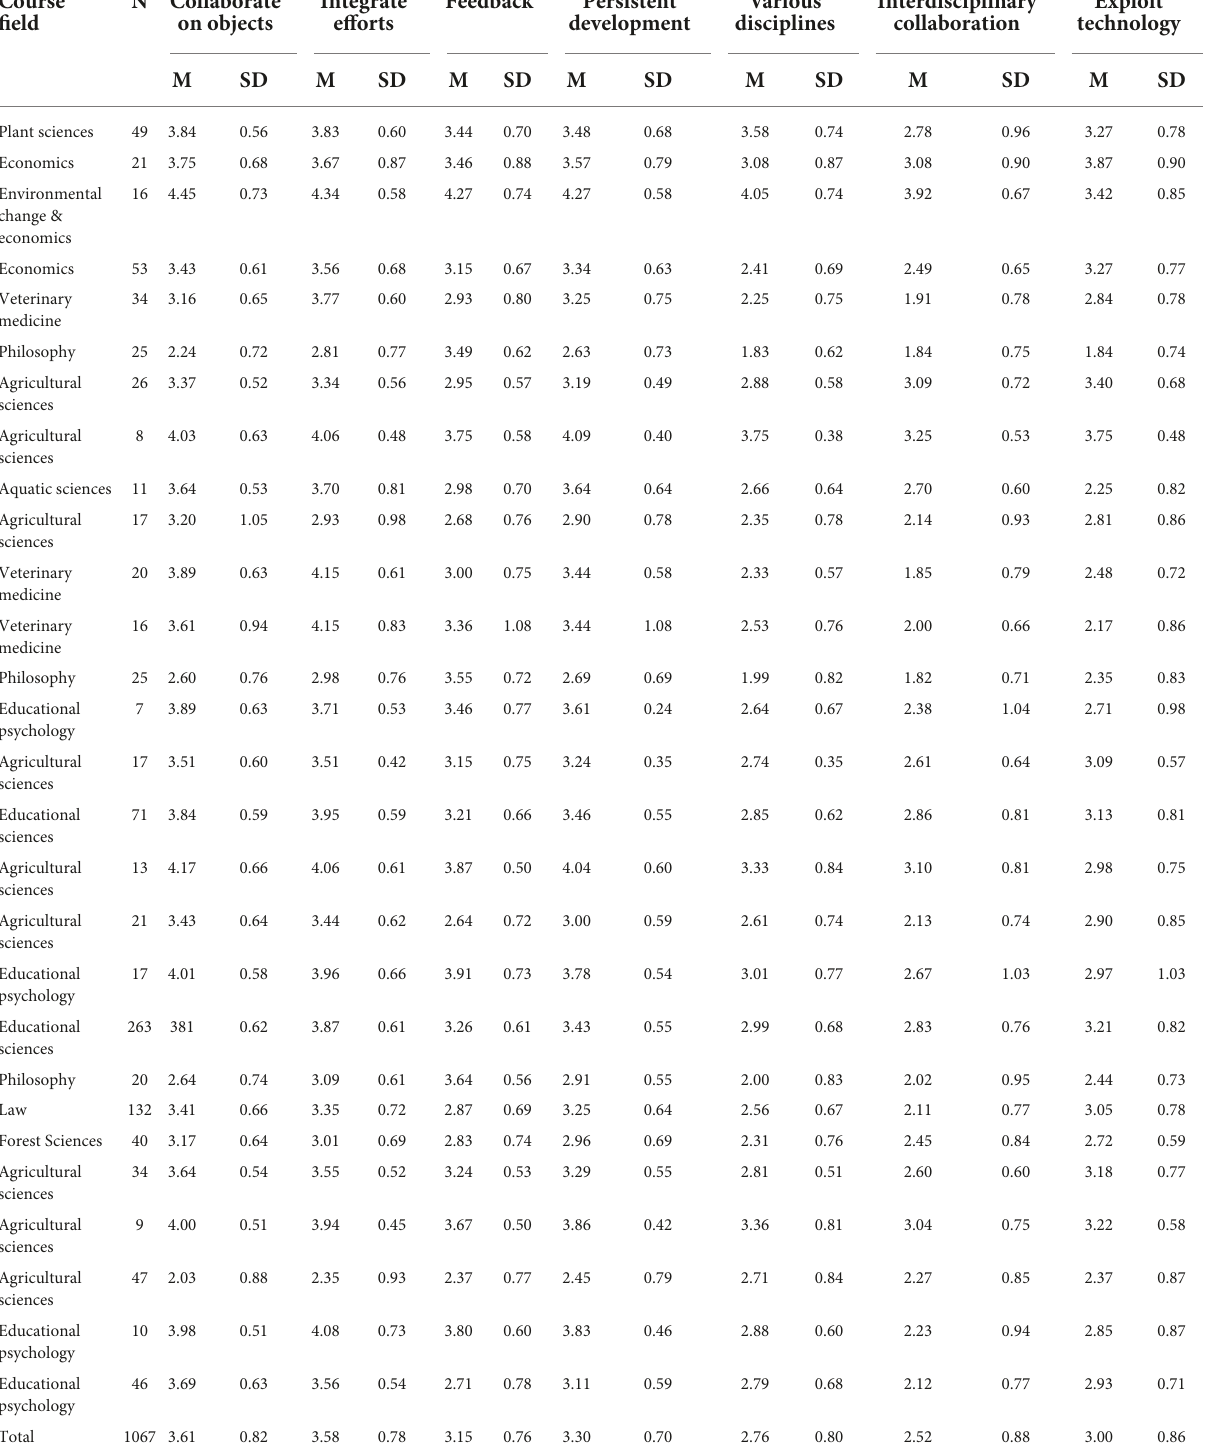
TABLE 3 Collaborative knowledge practices scale means and standard